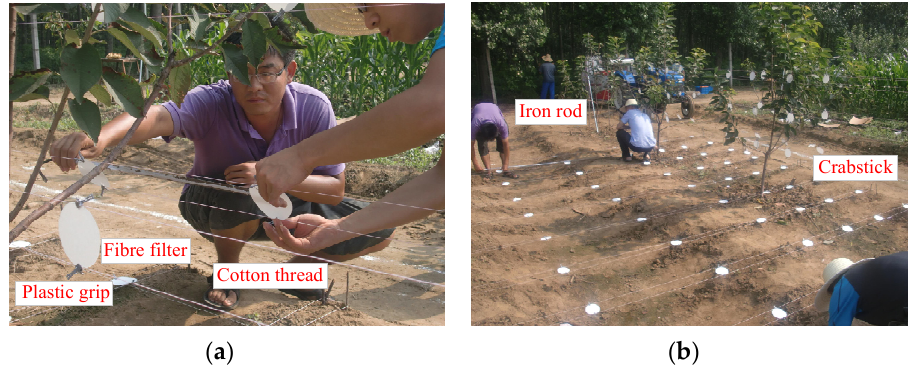
Agriculture 2021 , 11 , x FOR PEER REVIEW Figure 7. Sampling filter paper fixed: ( a ) canopy sampling points, ( b ) ground sampling points. The field site after setting the sampling points is shown in Figure 8, the key experi- ment parameters are list in Table 2, the L w values of the photoelectric-based target-ori- ented spraying controller were set to 1.2 m and 3.2 m for the cherry trees and apple trees, respectively. The sprayer was driven along a white centre line (Figure 8) to conduct con- ventional off-target spraying and target-oriented spraying with photoelectric sensors or ultrasonic sensors. At the end of each spraying operation, the filters at the sampling points were collected and placed in labelled plastic bags. Each test was repeated three times.